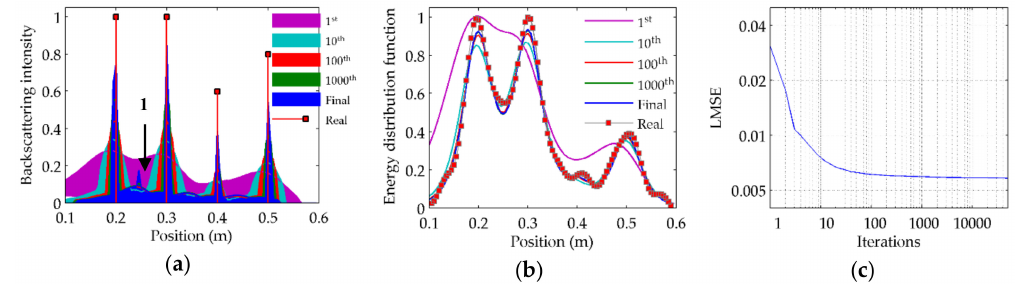
Figure 6. Inversion result for the multi-scatter scenario. ( a ) presents the distribution of the inverted backscattering intensity during the network training. The results of the 1st, 10th, 100th, 1000th and final iterations are illustrated with different colors (see the legend). Since the initial set is all zeros, it is not visible in the figure. A false pulse appears at 0.25 m, and is indicated with number 1, corresponding to Figure 5. ( b ) shows the evolution of the fitted energy distribution function. ( c ) gives the evolution of LMSE in the network training, i.e.,